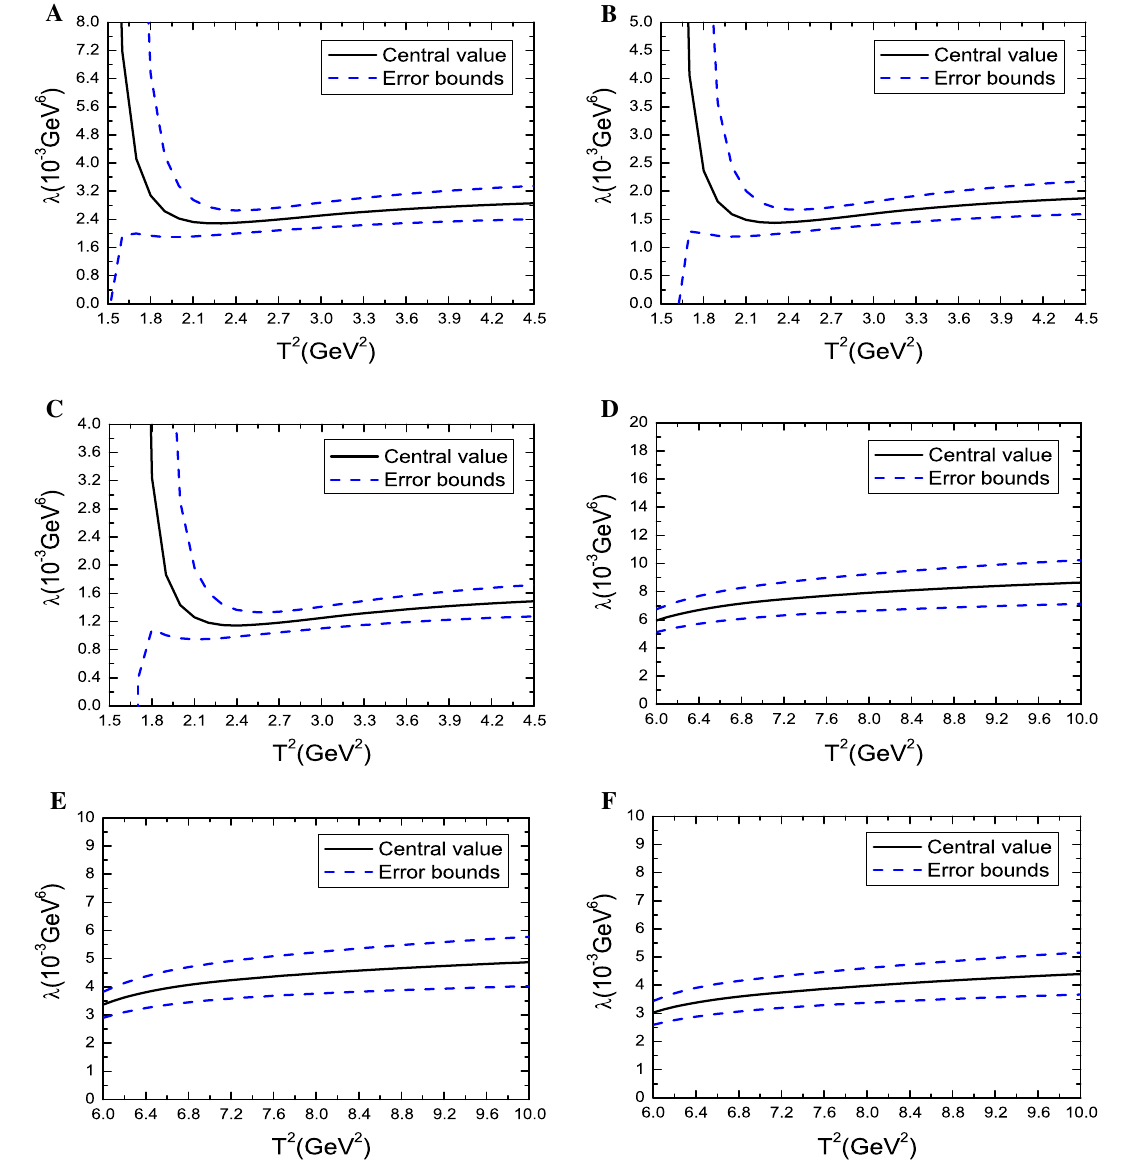
Fig. 7 The pole residues of the doubly heavy pentaquark states with variations of the Borel parameters T 2 , where the A , B , C , D , E and F denote the P , P , P , P , P and P , cc , 1 2 cc , 3 2 bb , 1 2 bb , 3 2 cc , 5 2 bb , 5 2